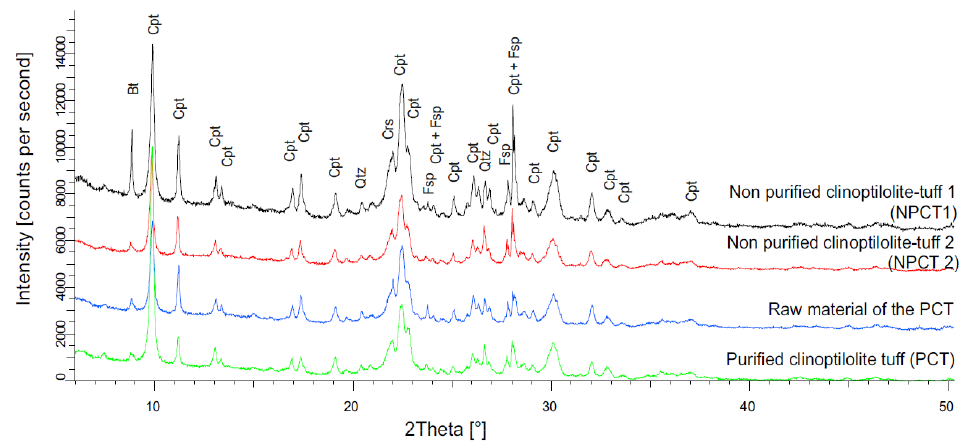
Figure 1. Powder XRD patterns illustrating the whole-rock mineral composition of the clinoptilolite tuffs. Cpt = clinoptilolite, Bt = biotite, Qtz = quartz, Crs = cristobalite, Fsp = feldspar.